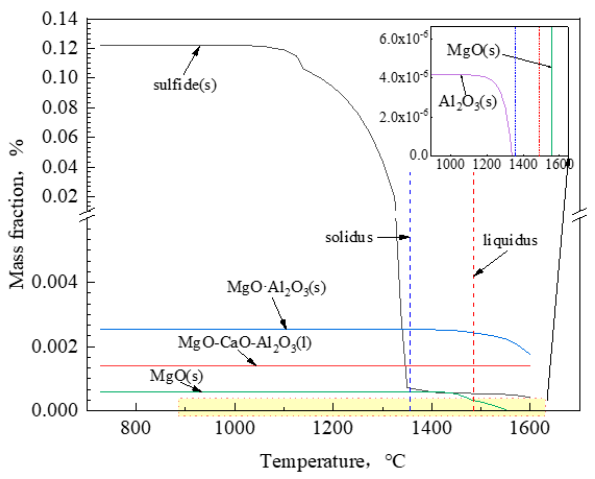
Figure 10. Inclusion content during solidification of sample S3.